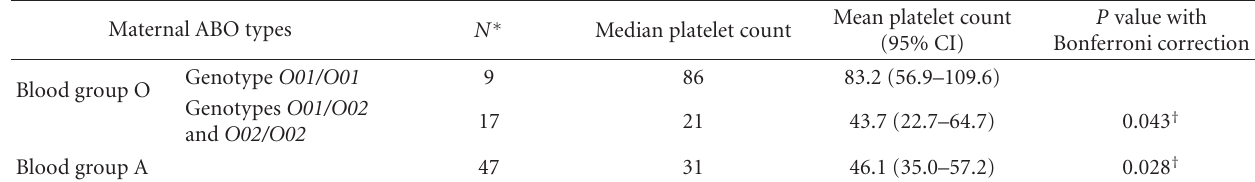
Table 2: Platelet counts in the newborns with